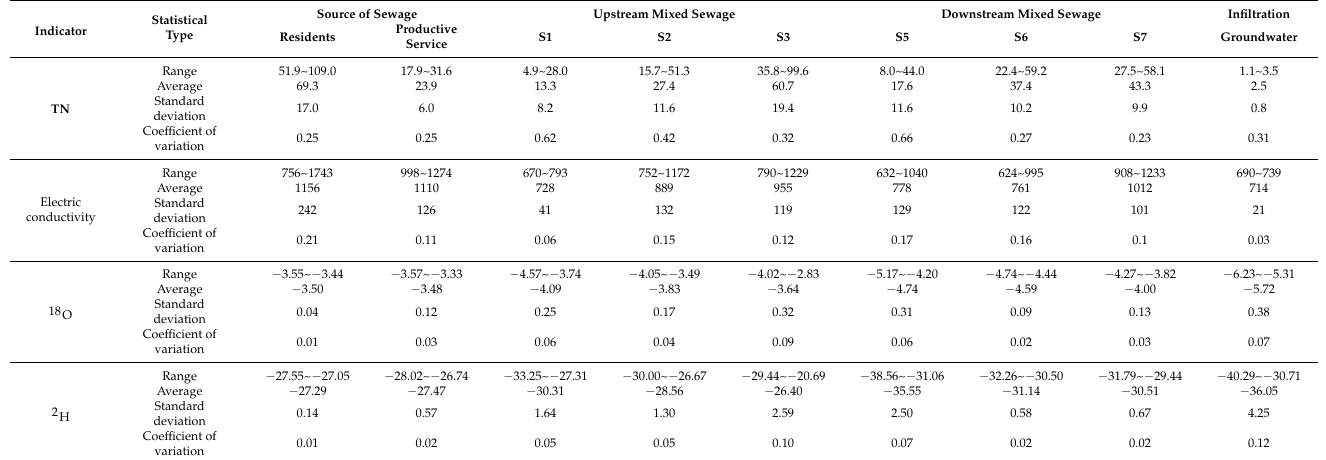
Table 1. Laboratory testing results of samples taken on dry